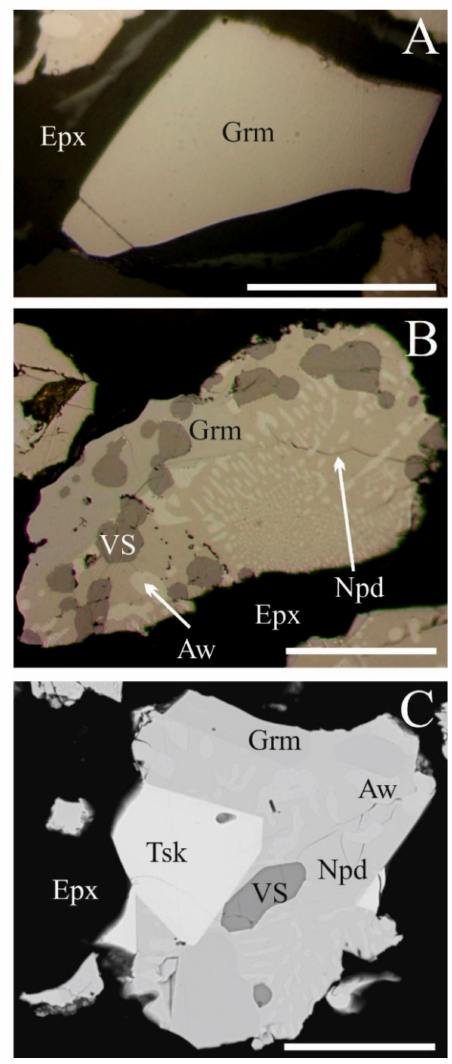
Figure 2. Digital image in reflected plane-polarized light ( A , B ) and a back-scattered electron image ( C ) showing grammatikopoulosite from the chromitite of Agios Stefanos. Abbreviations: Grm = grammatikopoulosite, Tsk = tsikourasite, VS = V-sulphide, Aw = awaruite, Npd = nickelphosphide, Epx = epoxy. Scale bar = 50 microns.